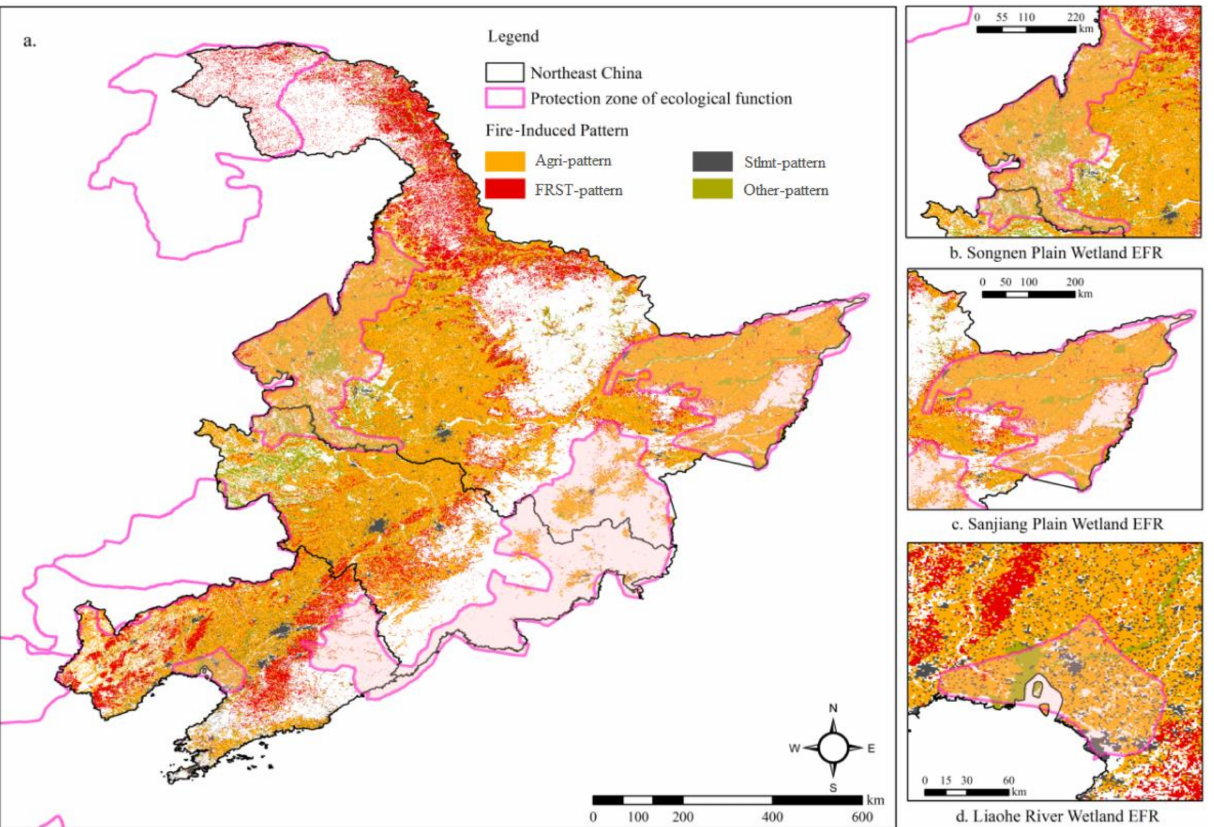
Figure 10. ( a ) Four types of fire-induced pattern in Northeast China. Note: ( b ) the Songnen Plain Wetland EFR, ( c ) the Sanjiang Plain Wetland EFR and ( d ) the Liaohe River Wetland